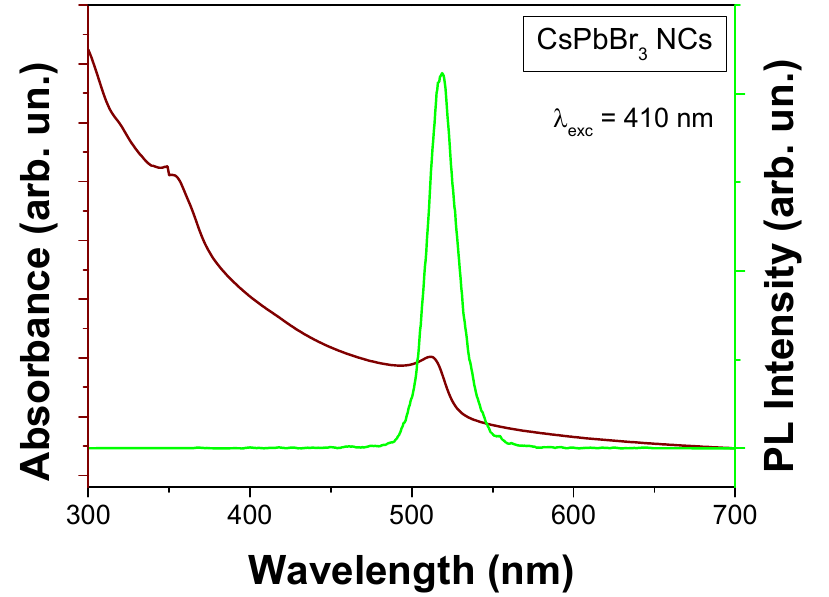
Figure 4. Absorption (brown) and emission (green) spectra of colloidal CsPbBr 3 NCs; λ exc = 410 nm. Figure 4 . Absorption (brown) and emission (green) spectra of colloidal CsPbBr 3 NCs; λ exc = 410 nm. The synthesis of NCs@NP Au followed two different procedures (detailed conditions are reported in Section 2.3). In procedure 1, a known amount of NP Au (70 mg) was incorporated into the hexane suspension of CsPbBr 3 NCs under ambient conditions. The concentration of the CsPbBr 3 NCs was 2 mg/mL. Figure 5 shows the pictures of the solution Figure 4 . Absorption (brown) and emission (green) spectra of colloidal CsPbBr 3 NCs; λ exc = 410 under UV light (375 nm), before and after the addition of NP nm.